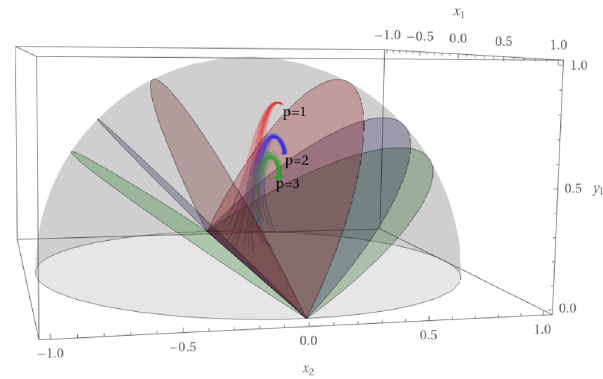
Figure 3 . Evolution of the two-field quintessence system inside the wedge free of Q-ball formation for universal string moduli and p = 1 , 2 , 3